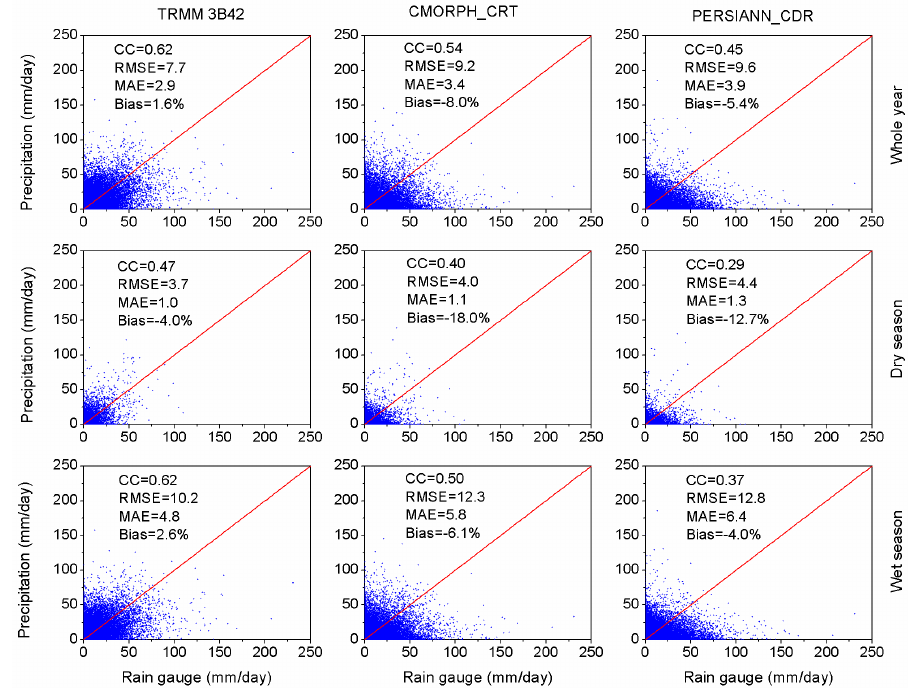
Figure 2. Scatterplots of daily precipitation from TRMM 3B42, CMORPH_CRT, and PERSIANN_CDR against ground observations at the grid scale: the three panels show the results from the whole year (upper panel), dry season (mid panel), and wet season (lower panel). The red line indicates a 1:1 correspondence.